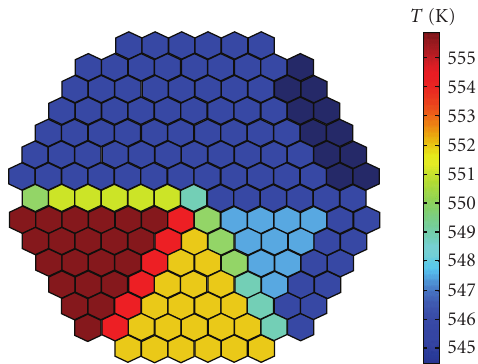
Figure 17: Predicted coolant temperature at core outlet at final state (1800